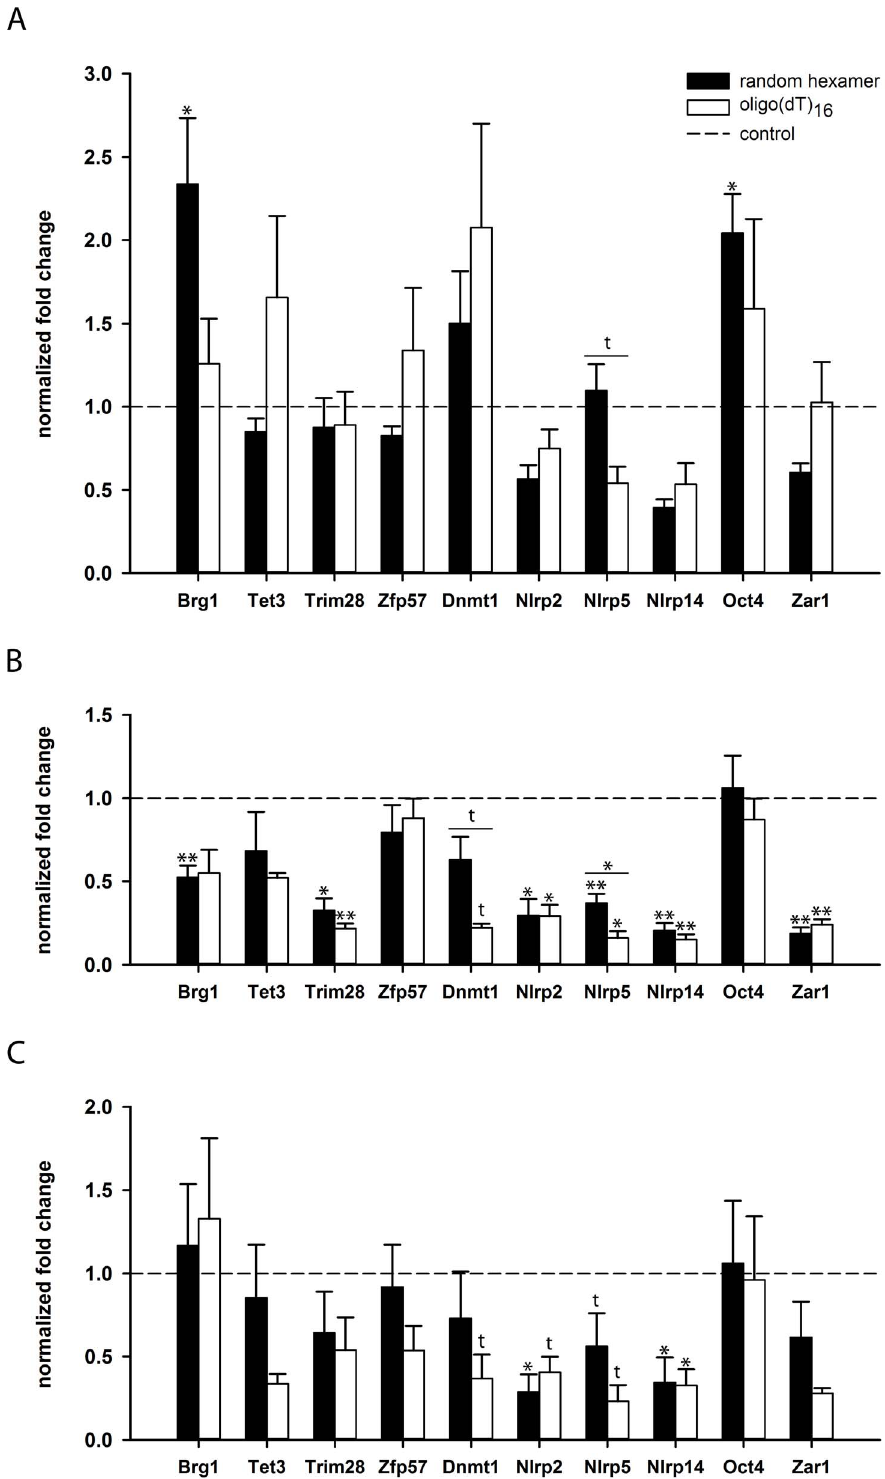
Figure 4. Expression levels and poly(A) content of ME genes in postovulatory-aged oocytes. The normalized fold change (mean 6 SEM) of postovulatory-aged oocytes compared to control oocytes (dotted line) of total transcript (black bars) and polyadenylated transcript (white bars) is shown. In vivo-grown oocytes were aged for 12 h (A) and 24 h (B). After 12 h of postovulatory aging, the stronger reduction of polyadenylated transcript in comparison to total transcript levels indicates a reduced poly(A) tail length for Nlrp5 . After 24 h, postovulatory aging results in